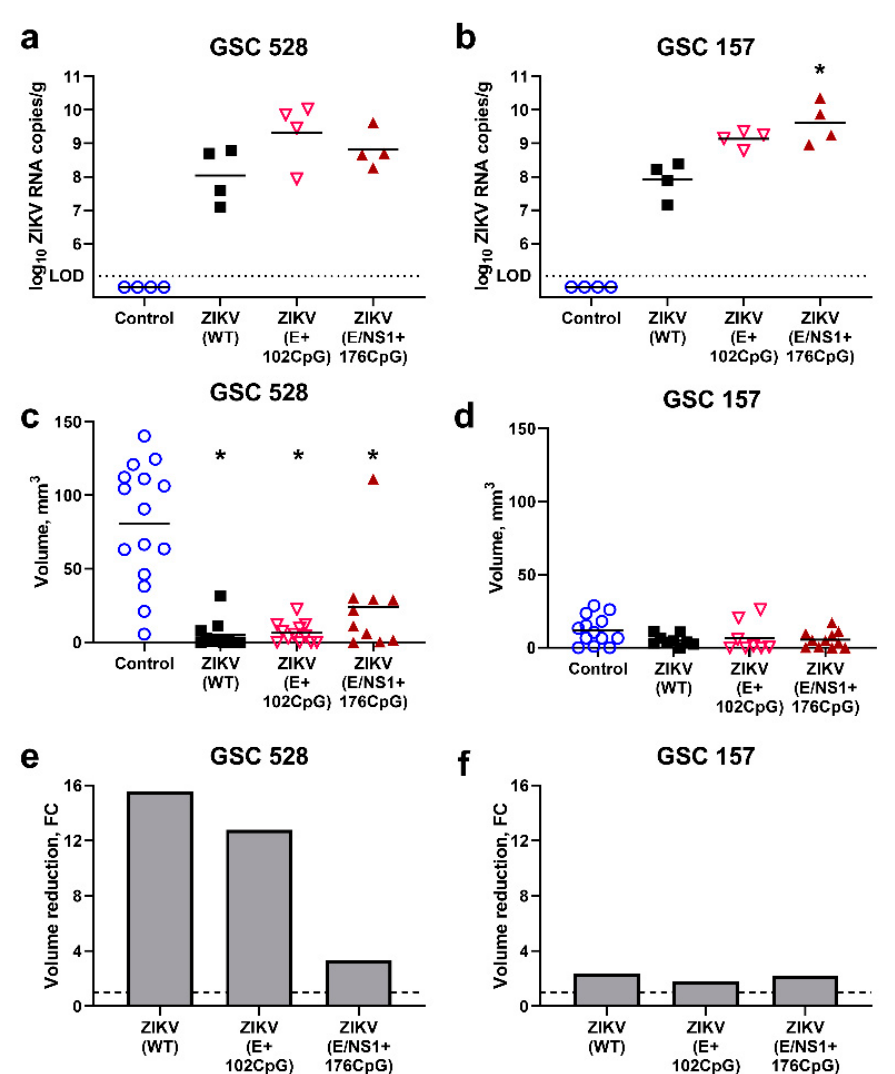
Figure 5. Zika virus (ZIKV) quantification in tumors (( a ) glioblastoma stem cells (GSC) 528; ( b ) GSC 157). The dotted line ( a , b ) represents limit of detection. The volume of tumors inoculated with ZIKV variants ( c : GSC 528; d : GSC 157). Relative reduction of tumors (( e ) GSC 528; ( f ) GSC 157); FC: fold change. *: p < 0.05; tumor volumes in ZIKV groups were compared to volumes in the control group. The dashed line ( e , f ) represents the base tumor volume in the control group. Sampling was performed at day 19 of embryonic development.